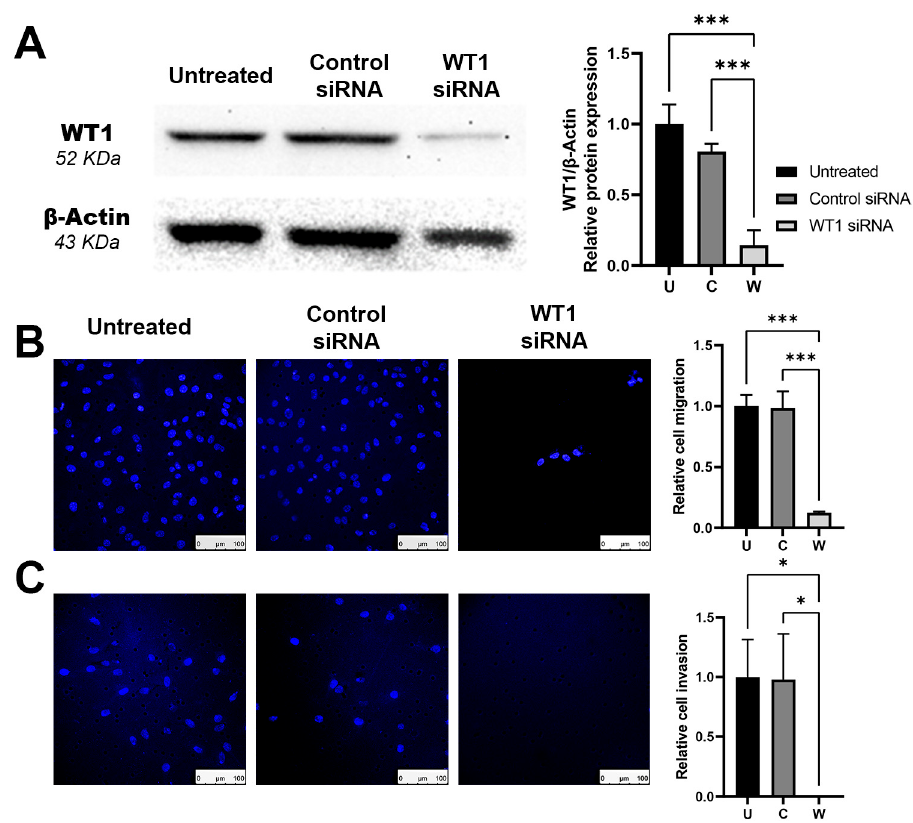
Figure 1. Effect of WT1 silencing over protein expression and cellular motility on melanoma cells. ( A ) Western blot showing silencing of the WT1 protein and densitometry quantification for each group after 72 h of treatment. ( B ) Cell nuclei stained with DAPI after WT1 silencing showing a reduced migration after 48 h and ( C ) a complete loss of invasion capacity through the Matrigel-transwell chamber after 72 h. Average number of nuclei per field was normalized to untreated group. Scale bars represent 100 µm. Groups U: Untreated, C: Control siRNA, W: WT1 siRNA. One-way ANOVA was used as statistical test for group’s comparison. * p < 0.05, *** p < 0.001.